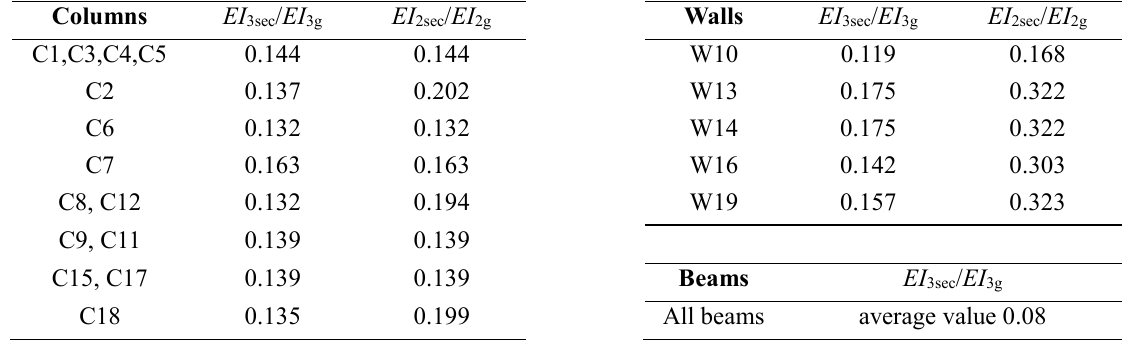
Beams EI 3sec / EI 3g 0.135 0.199 All beams average value 0.08 *local axis 3 and 2 are equivalent with the strong and weak structural elements